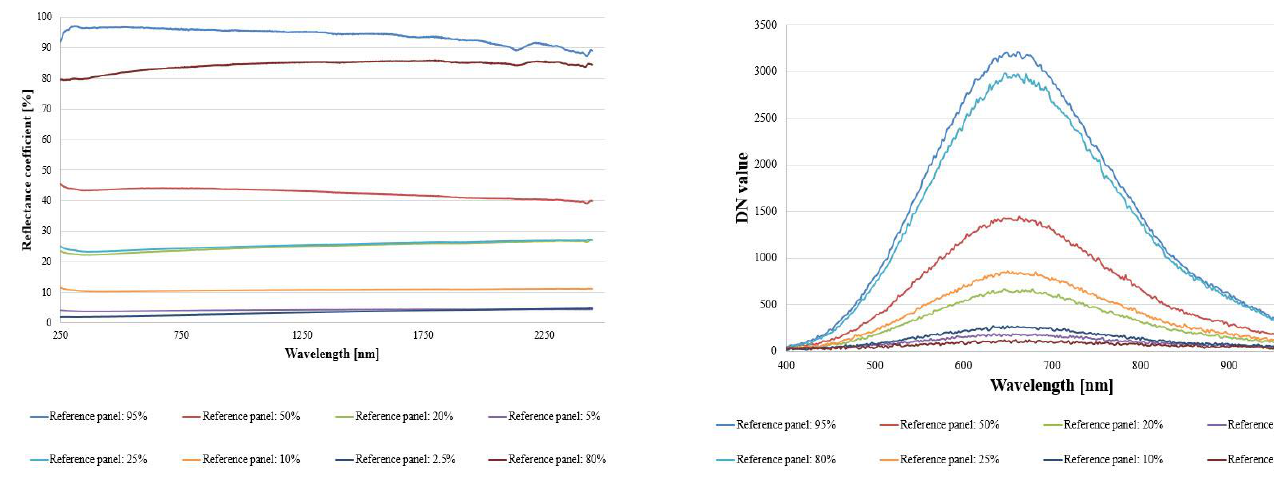
Figure 4. Spectral reflectance characteristics of reference reflectance panels used in the experiment